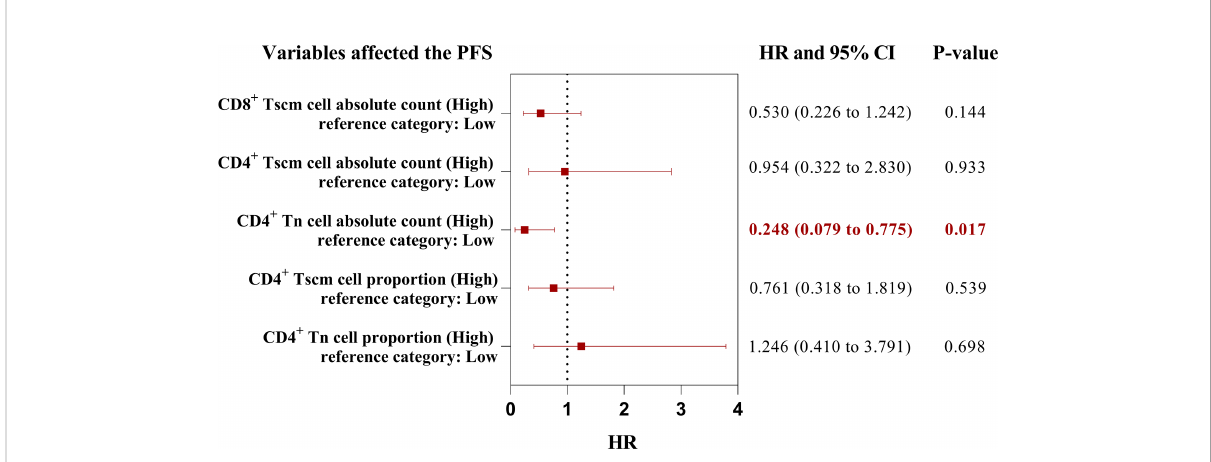
FIGURE 8 The forest plots of factors affected the PFS of aNSCLCs who received immunotherapy. HR > 1 represented variable was considered a negative factor; HR< 1 indicated variable was considered a positive